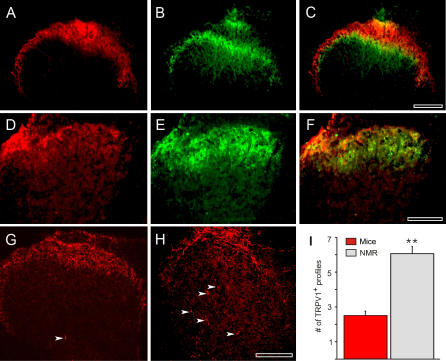
Comparison of TRPV1 Staining in the Spinal Cord of the Mouse and Naked Mole-RatSections were stained with a primary anti-rat TRPV1 antibody that was detected with a secondary antibody conjugated to Cy3 (red), sections were co-stained with IB4 conjugated to Alexa-488 (green).(A–C) TRPV1 and IB4 staining is localized to the superficial laminae of the dorsal horn in the mouse.(D–F) Similar staining is observed in the naked mole-rat, although a thicker lamina II gives rise to increased IB4 staining.(G) Very little TRPV1 deep staining is observed in the mouse.(H) Deep TRPV1 staining is frequently observed in the naked mole-rat; white arrows highlight TRPV1 positive profiles in deeper laminae.(I) Quantification of TRPV1-positive profiles in deep dorsal horn of mouse and naked mole-rat. Scale bars for (A–H) are 100 μm.